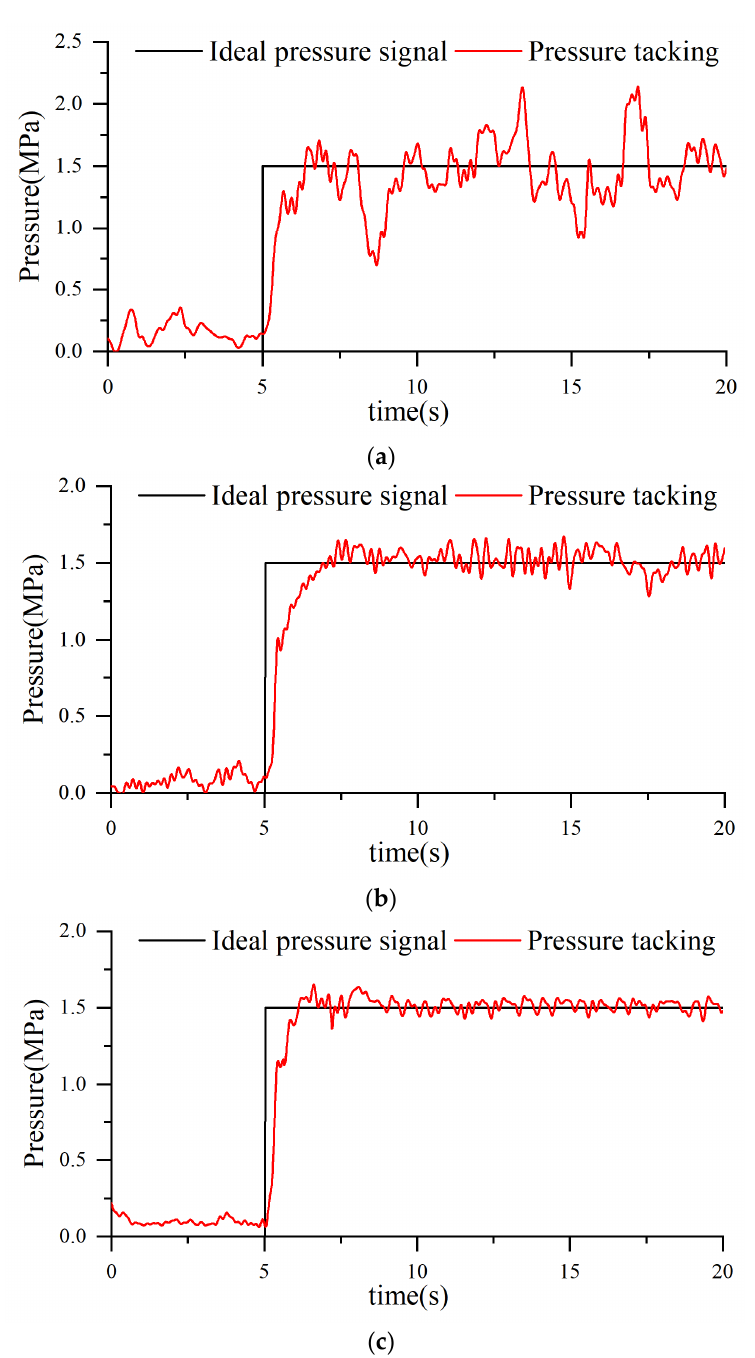
Figure 13. Dynamic characteristics of pressure control: ( a ) Traditional PID; ( b ) Traditional PID with compensation correction; ( c )Adaptive fuzzy PID with compensation correction.